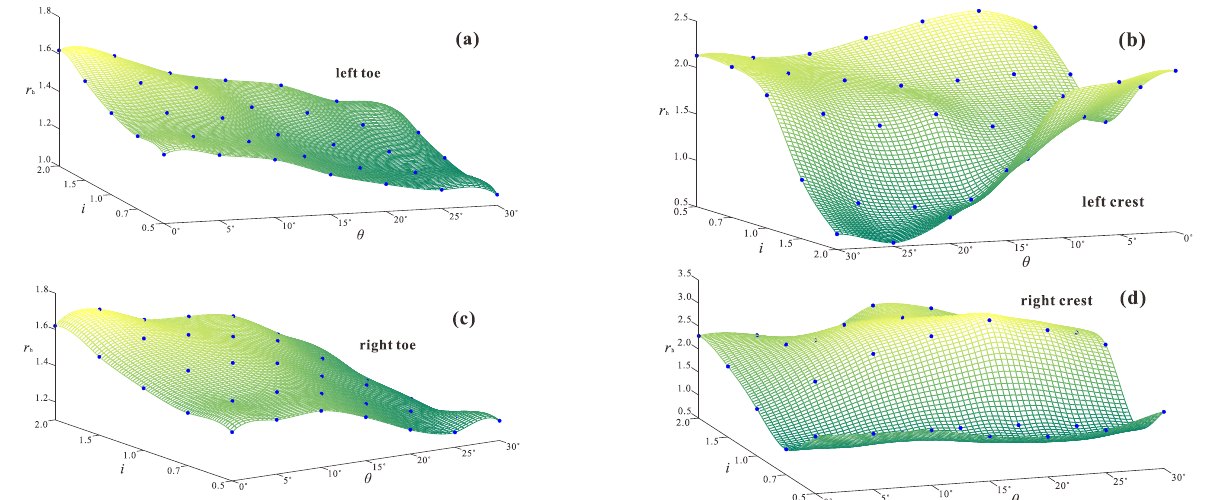
Figure 25. Variations of the horizontal amplification ratios ( r h ) of PGA at the observation points (( a ) left toe, ( b ) left crest, ( c ) right toe and ( d ) right crest) with varied angles of wave incidence at different slope inclinations.